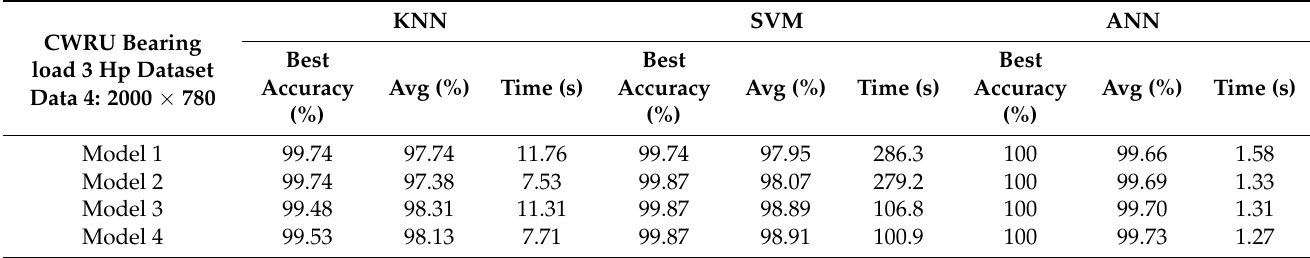
Table 9. Result in CWRU bearing load 3 Hp